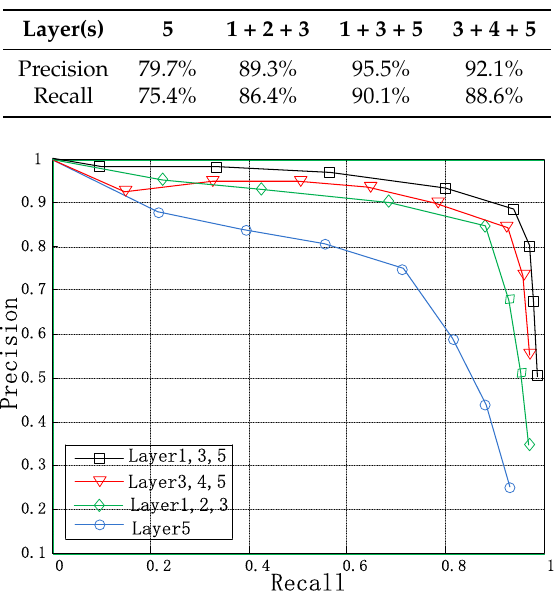
Table 2. Simulation experiment results from fusing the features of different layers.